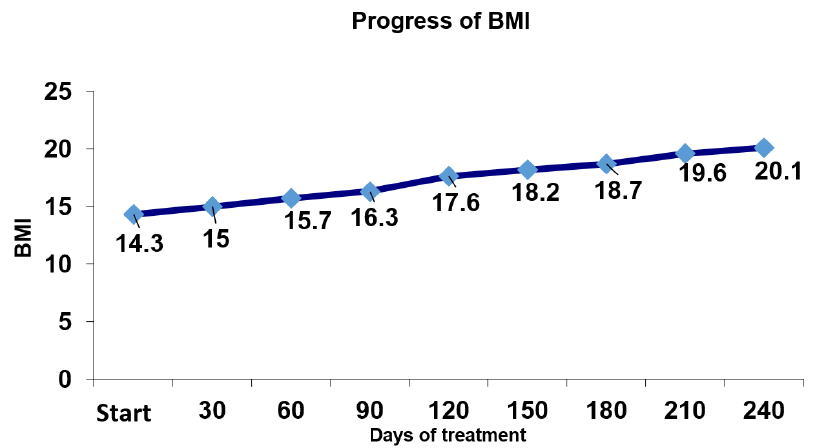
Figure 1. Progress of body mass index (BMI) over the course of therapy.